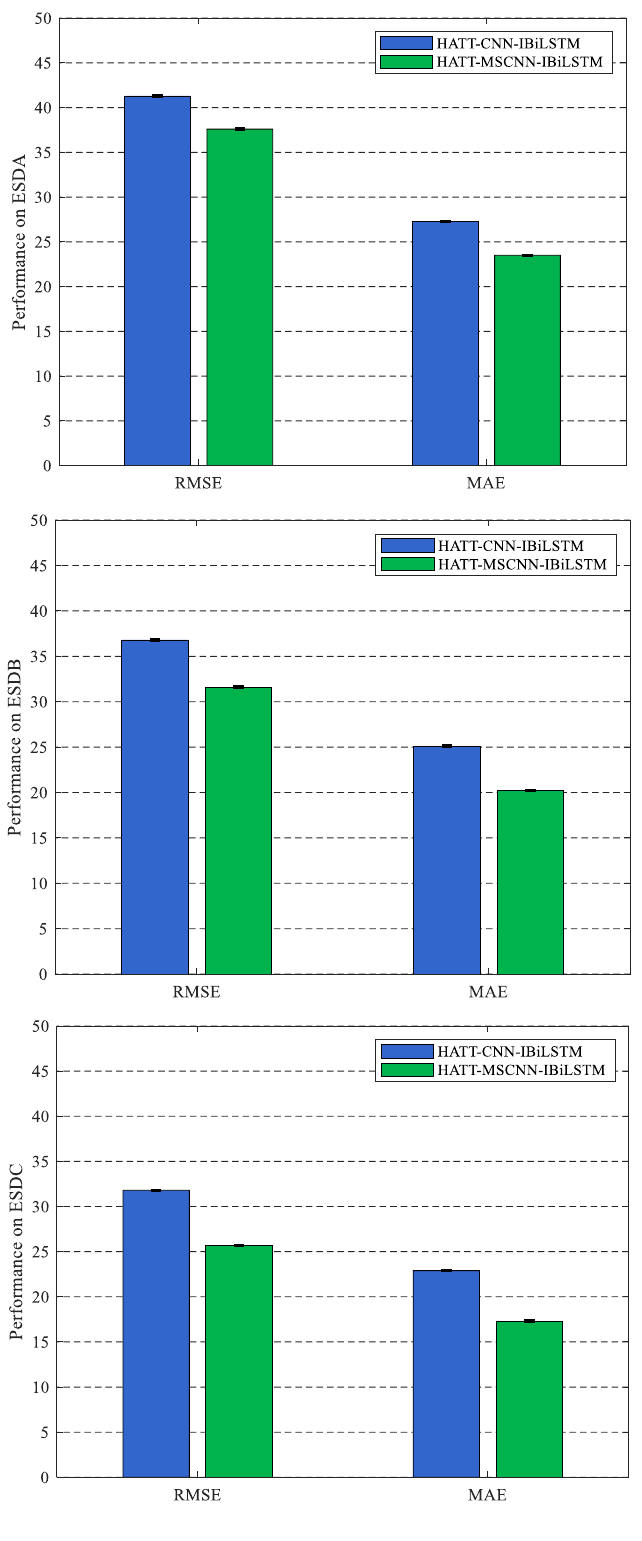
Fig. 13 Analysis on